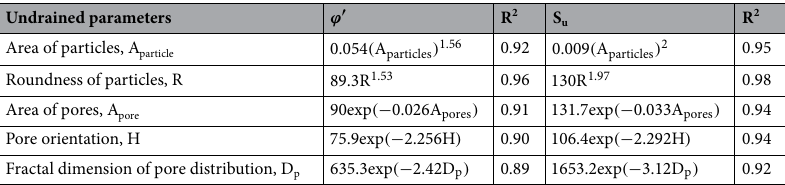
Table 7. Summary of trendlines between undrained shear parameter and microscopic soil index.